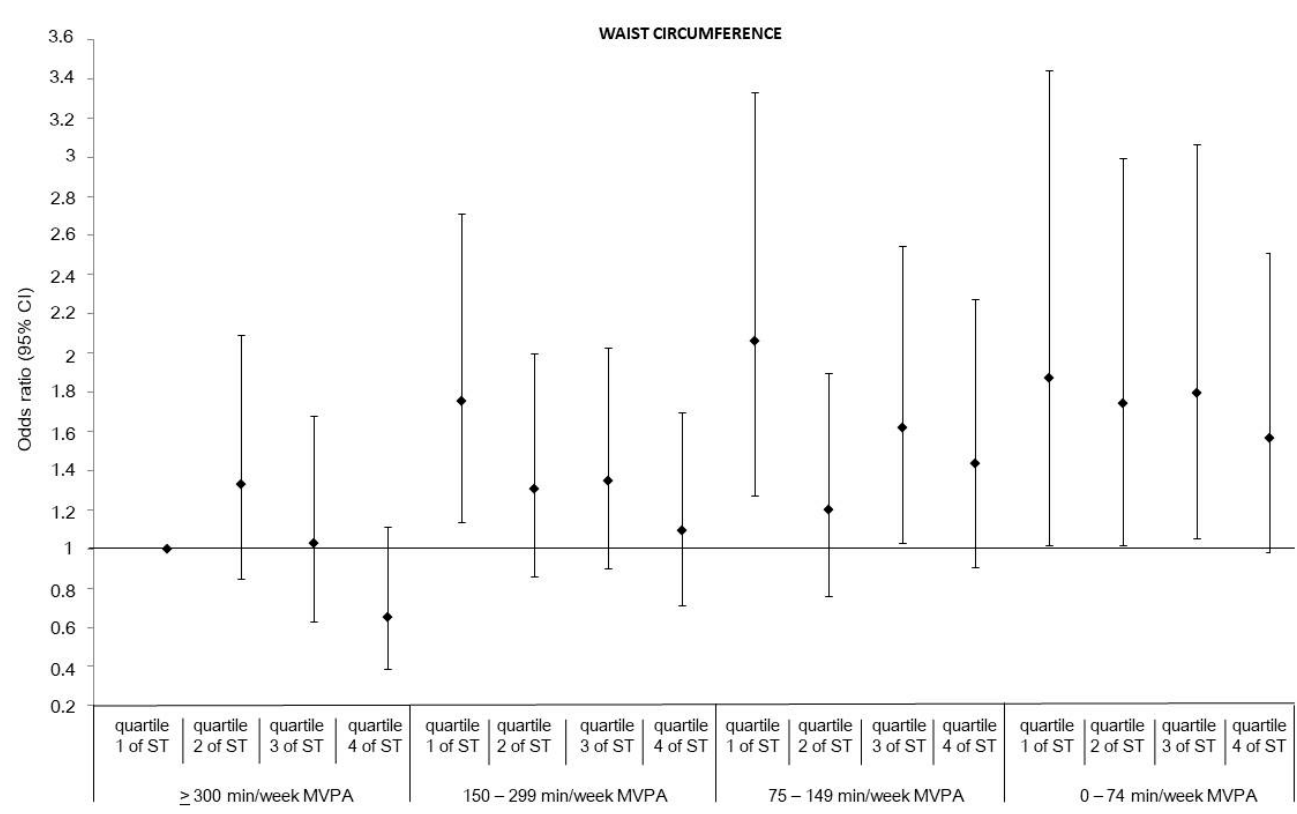
Figure 3. Joint associations of sedentary time and moderate-to-vigorous physical activity with obesity by waist circumference. The analyses were adjusted for country, sex, age, marital status, socioeconomic status, and race/ethnicity.